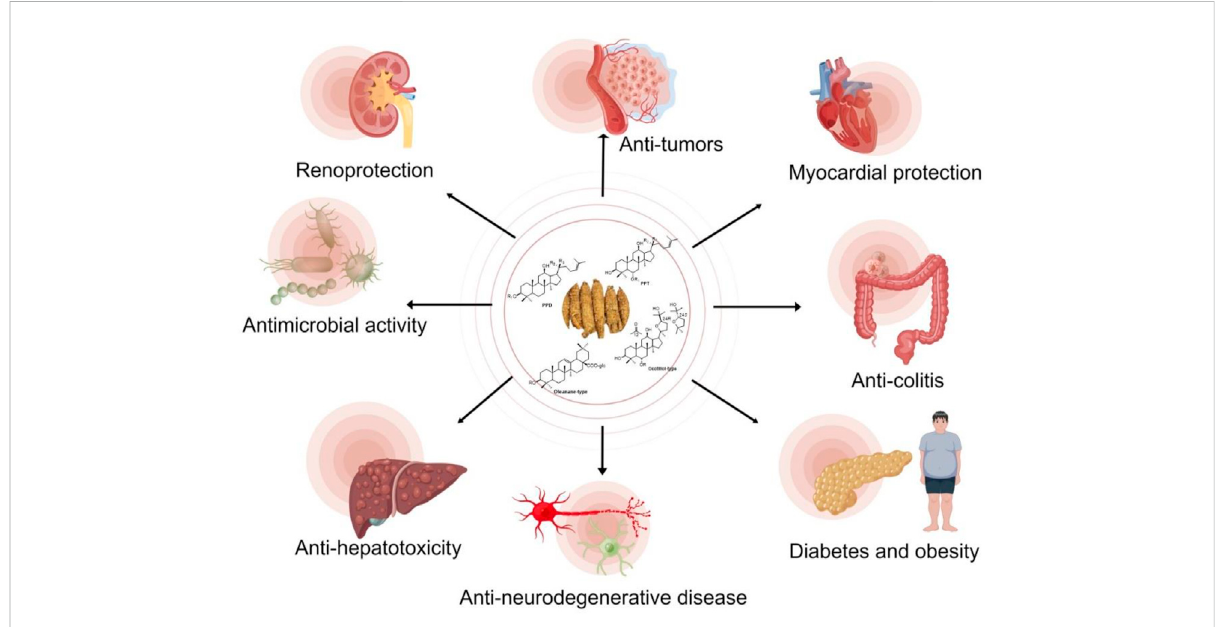
FIGURE 6 Biological and pharmacological activities of P. quinquefolius and its derived